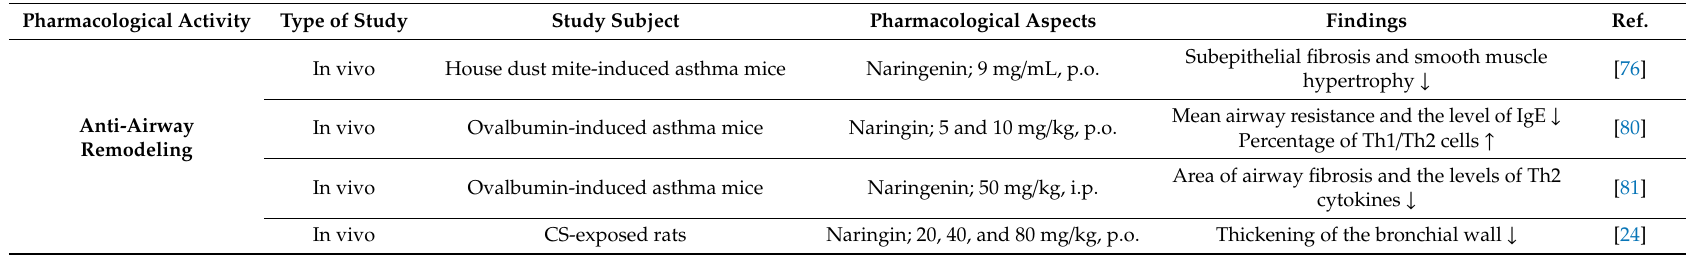
Table 3. Summary of anti-airway remodeling activities of naringenin and